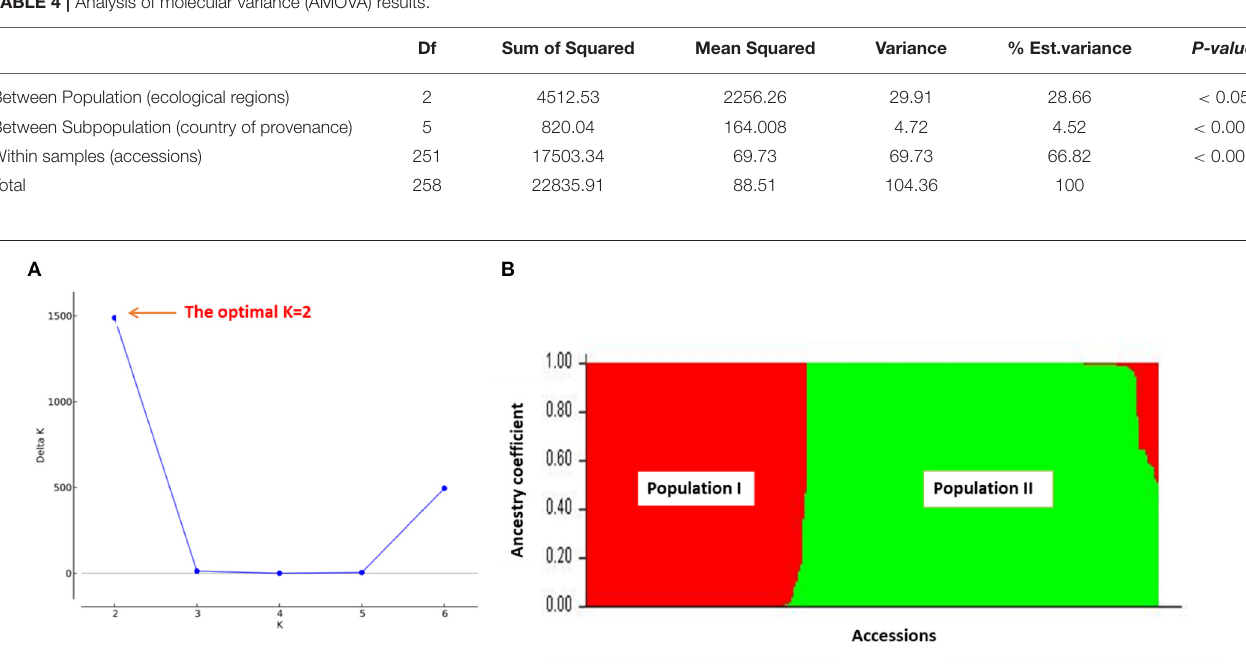
FIGURE 3 | The STRUCTURE results of 259 fonio accessions using 688 SNP markers: ( A ) the optimal value of K ( K = 2); ( B ) Bar plot of accessions showing two subpopulations (Population I = red color and Population II = green